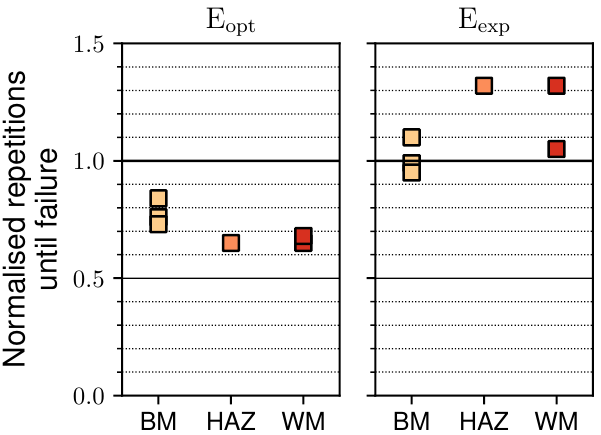
Figure 11. Normalized repetitions until failure for each material zone calculated using the Palmgren– Miner damage rule and the mean stress corrected strain–life equation. A normalized result of less than 1.0 indicates a conservative result, while a result above one 1.0 indicates a non-conservative